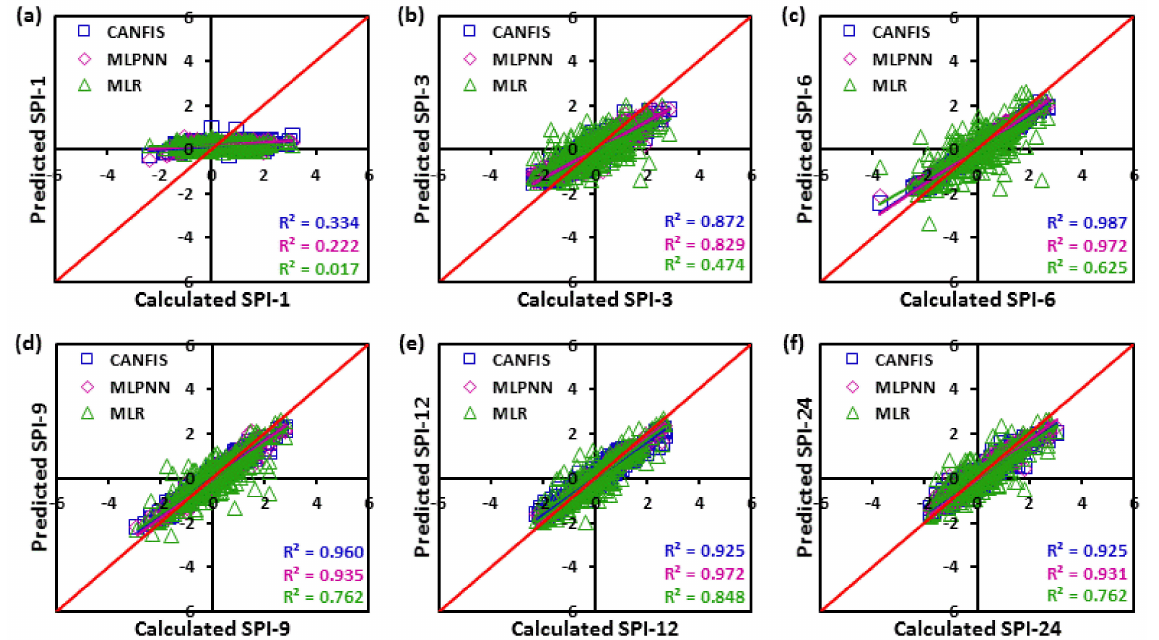
Figure 6. ( a – f ) Scatter plots of calculated and predicted multi-scalar SPI values by CANFIS, MLPNN, and MLR models during the testing period at Haridwar station.